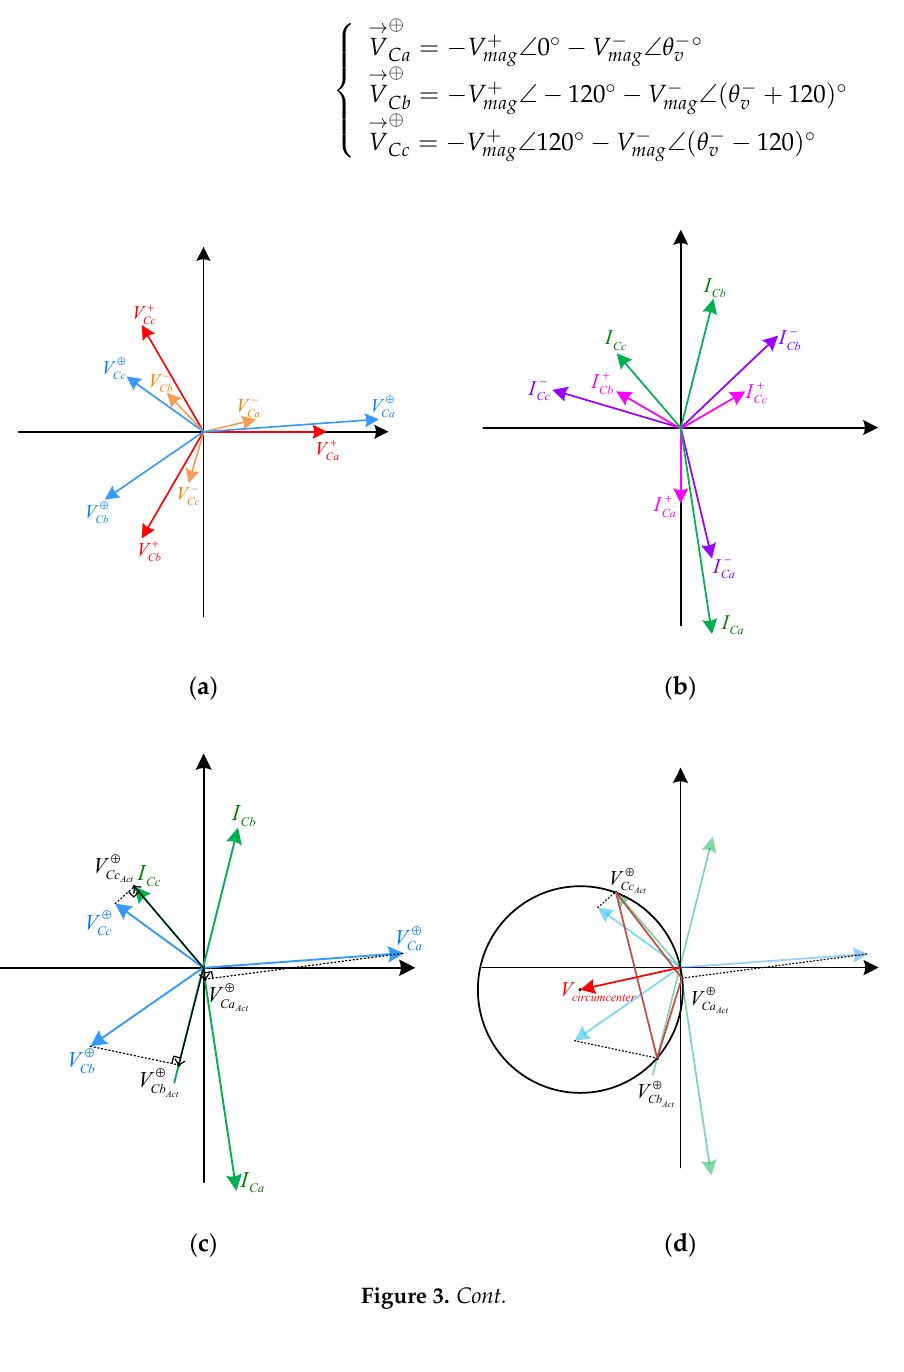
in Figure 3d. The zero-sequence voltage vec-